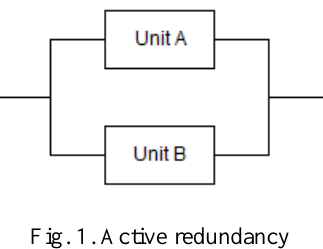
Fig. 1. Active redundancy